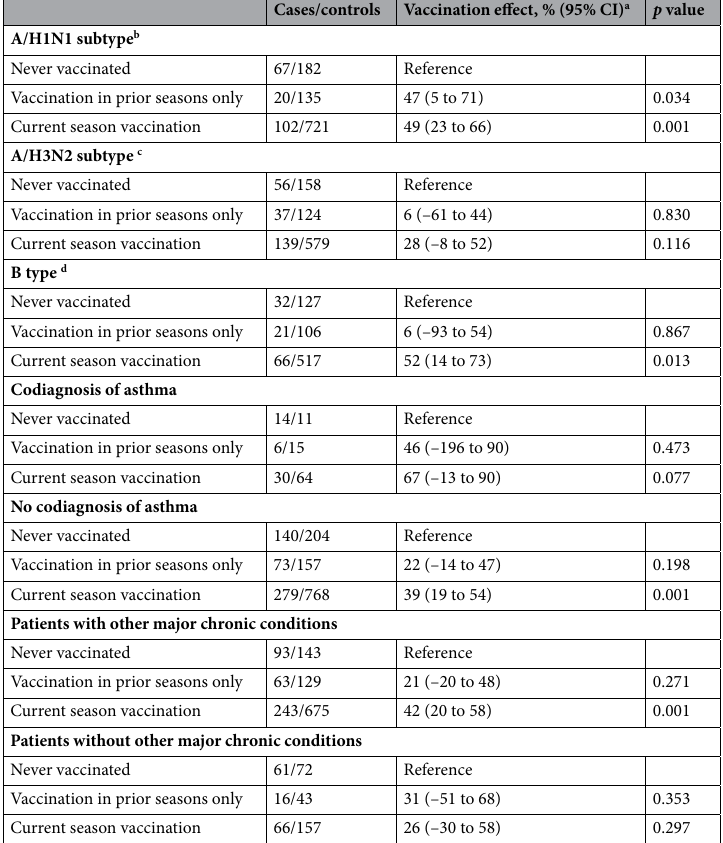
Comparison of target population for influenza vaccination with and without COPD. A total of